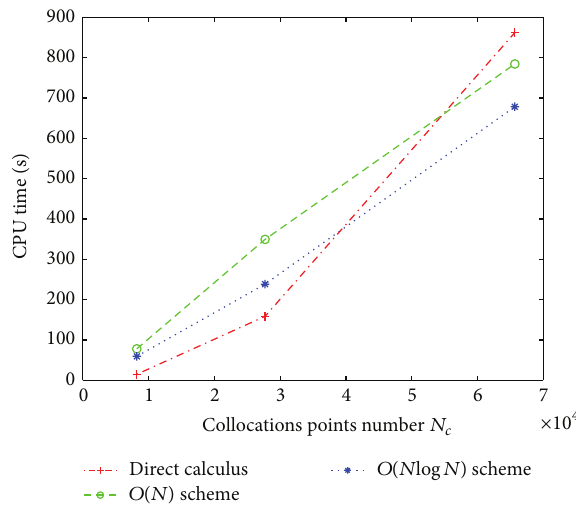
Figure 15: CPU time of the direct calculus and the two schemes 𝑂(𝑁 log 𝑁) and 𝑂(𝑁) versus the level for several values of 𝑁